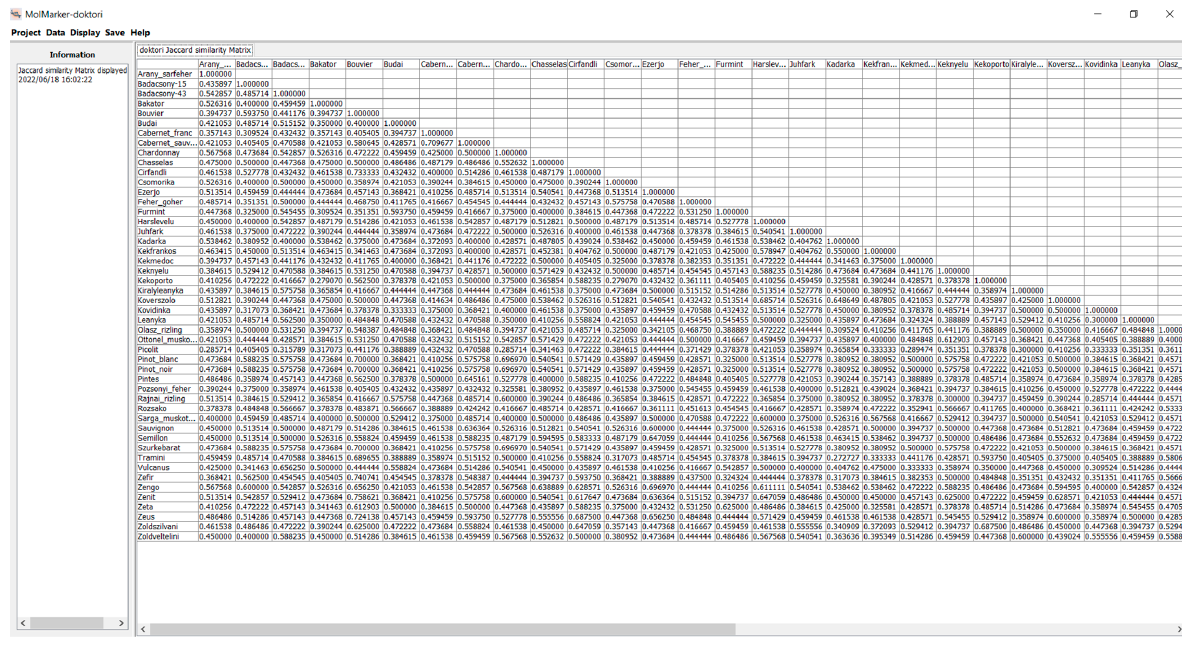
Figure 5. Similarity matrix using Jaccard similarities of SSR